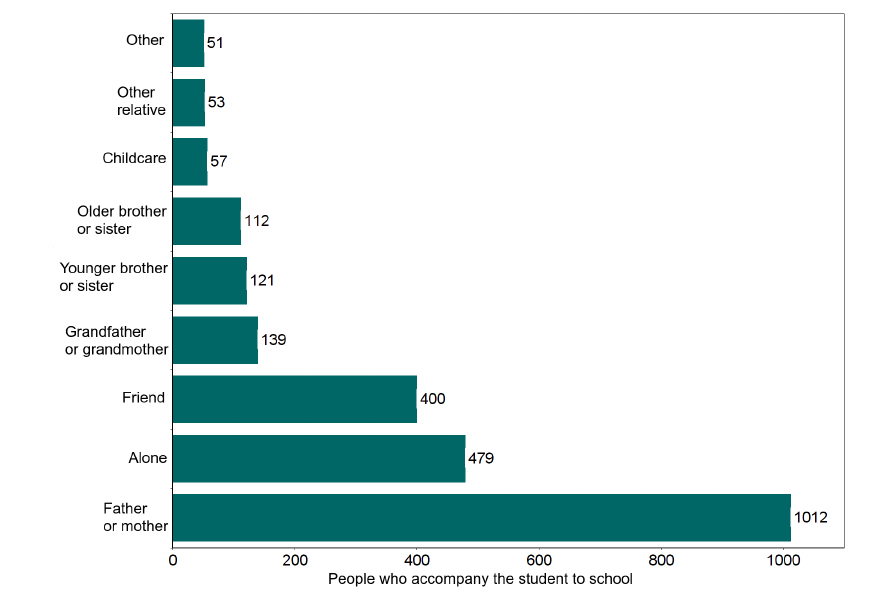
Figure 4. Most common means of transport on home–school routes.